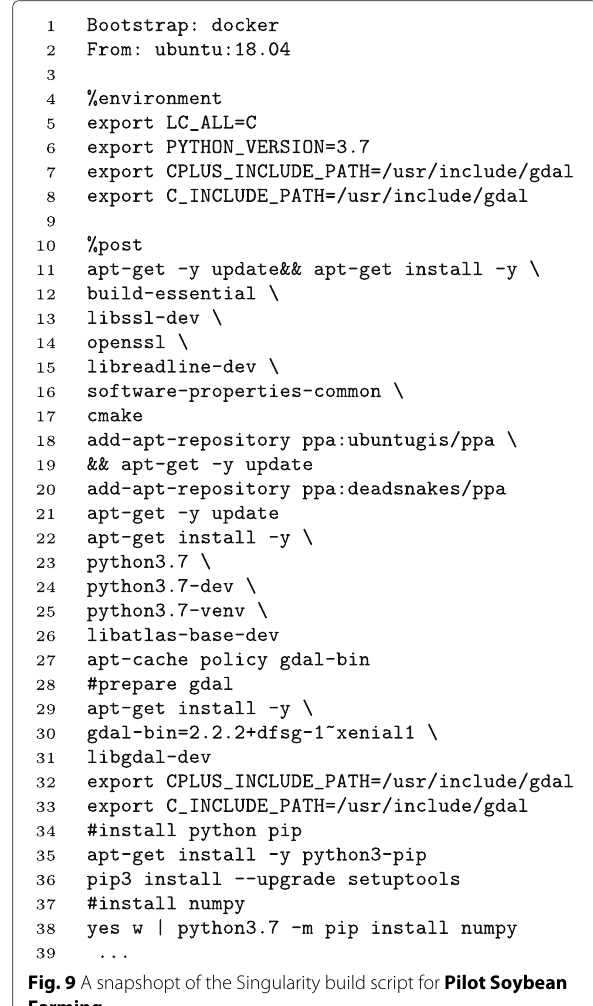
it still lacks the capability of concurrent submissions from multiple users. We propose to add this feature to a future release of Torque-Operator.